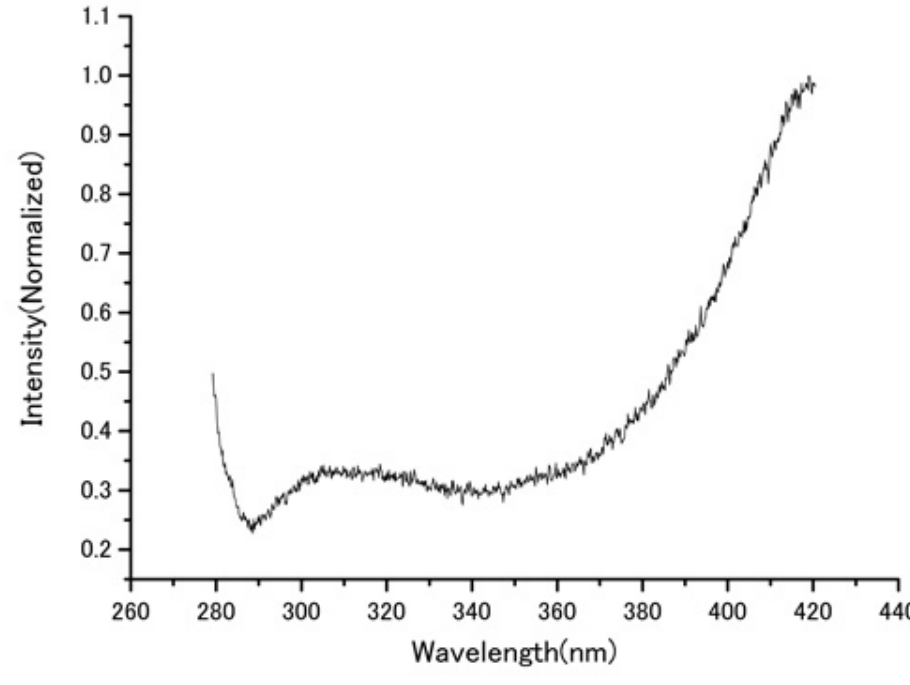
FIGURE 5. Fluorescence spectrum of fingerprint after 210-min illumination. This spectrum was measured with 10-nsec delay